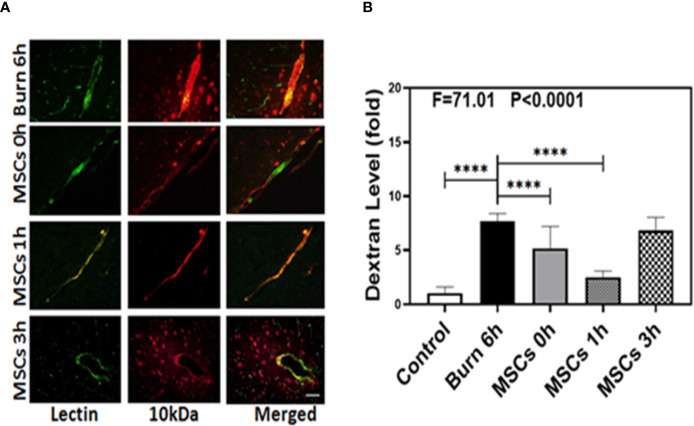
Umbilical cord-derived mesenchymal stem cells (UC-MSCs) alleviate the leakage of blood–brain barrier after burn. (A). Immunostaining of blood vessels (lectin, green, the first column) and dextran (10-kDa dextran, red, the second column) of the brain section following the burn in mice after 6 h (the first row), the UC-MSCs in mice at 0 h after burn (the second row), the UC-MSCs in mice at 1 h after burn (the third row), and the UC-MSCs in mice at 3 h after burn (the fourth row). All mice treated with UC-MSCs were extracted at 6 h after burn. The third column is the merged image of the first and second columns. The red spots (non-overlap area) in the third column indicate the dextran that is not inside the blood vessel (extravascular dextran). N = total of 90 slides from six mice in each group. Scale bar, 50 µm. (B). Spectrophotometric quantification of brain dextran shows that the UC-MSCs decreases extravascular 10-kDa dextran level in the mouse brain tissues as compared to that in the control condition (white bar) at 0 and 1 h (gray and dot bar) after burn and the best result is at 1 h (dot bar) after burn. N = 6 in each group. (****p < 0.0001).